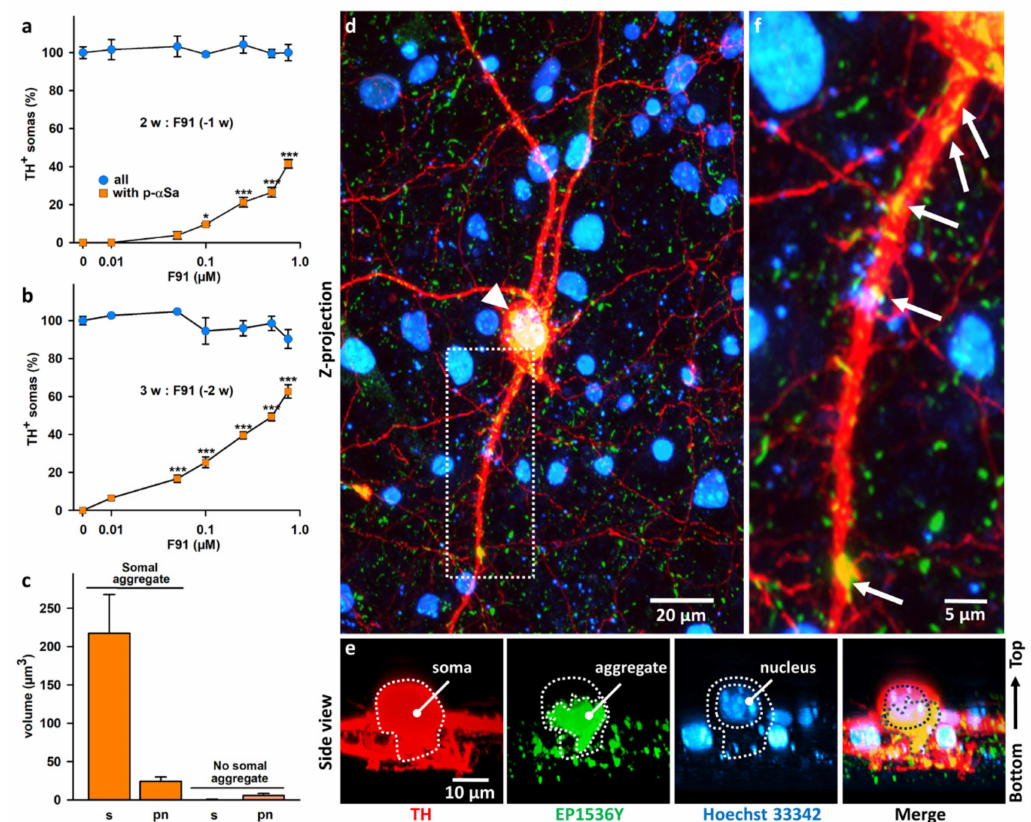
Figure 2. Quantitative and qualitative evaluation of α S seeded aggregation in midbrain cultured DA neurons. ( a ) Percentage of DA (TH + ) cell somas with p- α Sa and survival of these neurons in two-week midbrain cultures exposed one week earlier ( − 1 w) to increasing concentrations of F91 (0.01–0.75 µ M = 0.14–10.7 µ g/mL). ( b ) Same parameters as in ( a ) measured in three-week midbrain cultures exposed two week earlier ( − 2 w) to the same concentrations of F91. Data in ( a , b ) are means ± SEM ( n = 3–10). * p < 0.05; *** p < 0.001 vs. controls. One-way ANOVA followed by Dunnett’s test. ( c ) Average volume occupied by α Sa in the somas (s) and proximal neurites (pn)